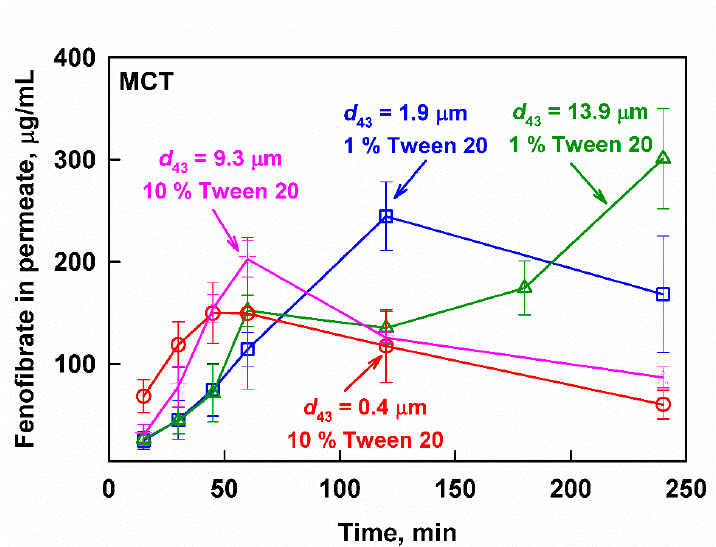
Figure 7. Fenofibrate measured in the aqueous phase after filtration as a function of the digestion time at simulated intestinal conditions of MCT emulsions with d 43 = 0.4 µm (10 wt% emulsifier, red circles), d 43 = 1.9 µm (1 wt% emulsifier, blue squares), d 43 = 9.3 µm (10 wt% emulsifier, pink stars) and d 43 = 13.9 µm (1 wt% emulsifier green triangles).